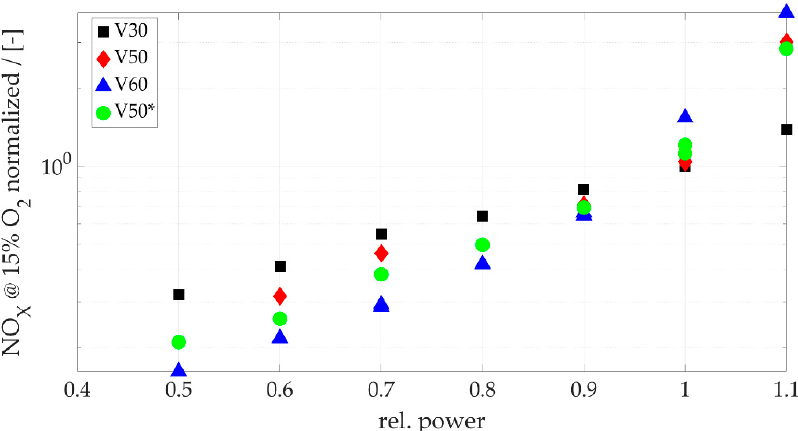
Figure 14. Comparison of the normalized NO X emissions (in logarithmic scale) of main liquid-fuel nozzles with different spray opening angles (V30, V50, and V60) and flow number (V50 and V50*) with respect to the relative engine power.